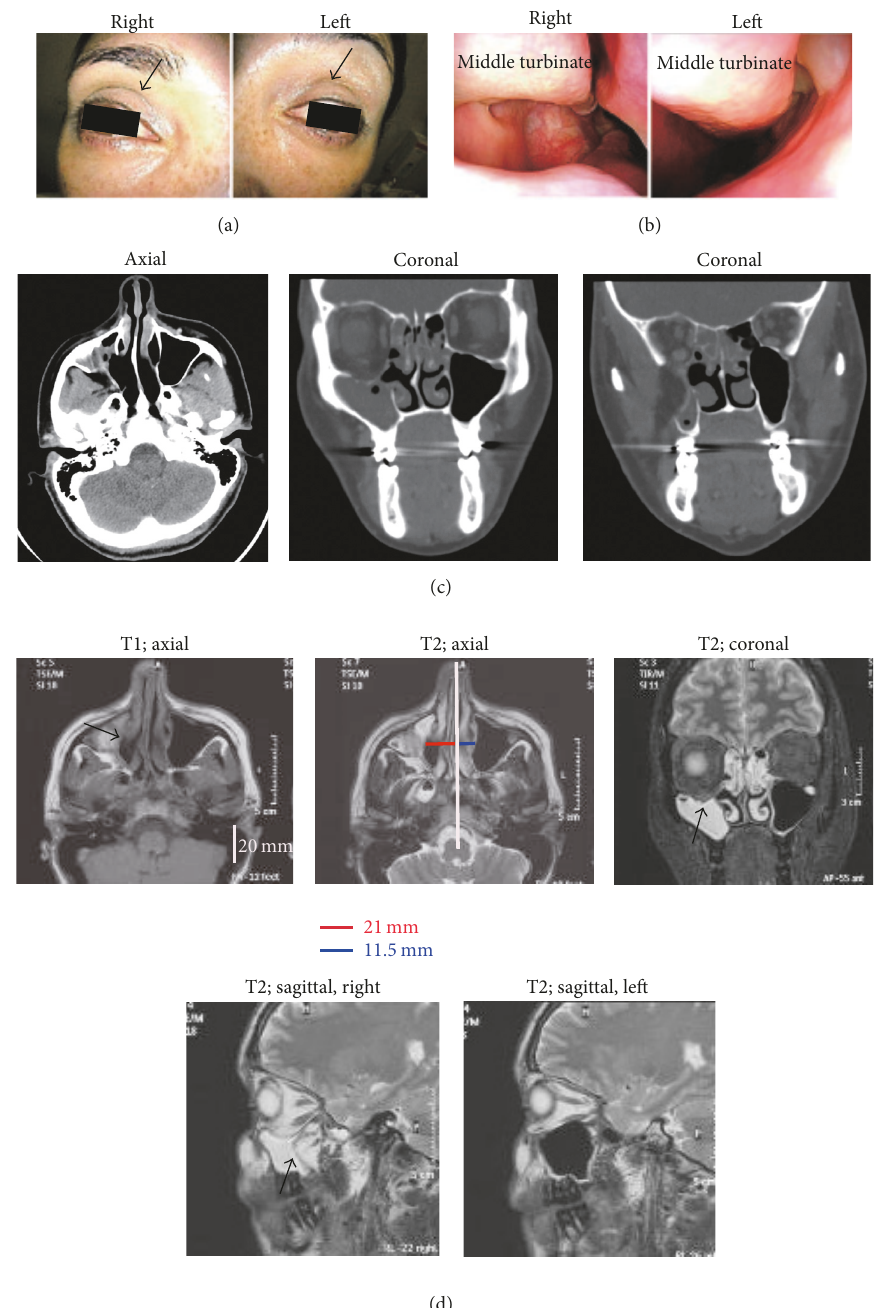
Figure 1: Summary of the clinical examination at the time the patient presented at our hospital. (a) Facial appearance: the arrows in the right and left pictures indicate the superior sulcus. The right superior sulcus appears to be deeper than the left superior sulcus. (b) Endoscopic findings: the right middle meatus is more enlarged than the left middle meatus. (c) Axial and coronal views on computed tomography. (d) T1 and T2 weighted images on magnetic resonance imaging. The T1 axial image shows that the right medial wall of the maxillary sinus (shown by the arrow) deviates laterally. The T2 coronal image indicates inferior bowing of the inferior wall of the orbit (shown by the arrow). The T2 sagittal images show prominent deviation of the posterior wall in the right maxillary sinus (shown by the arrow in the right image) relative to the structure in the left maxillary sinus (left image). The red and blue lines in the T2 axial image indicate the distance from the center line to the most deviated medial wall of the maxillary